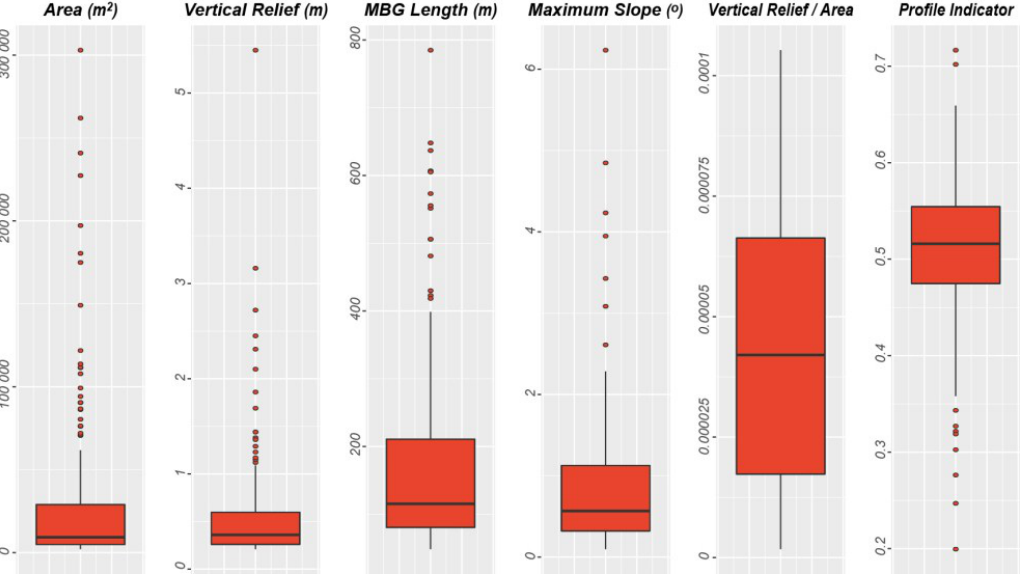
Figure 17. Boxplots for Area, MBG Length, and Vertical Relief for pockmarks mapped in the Malin Basin.